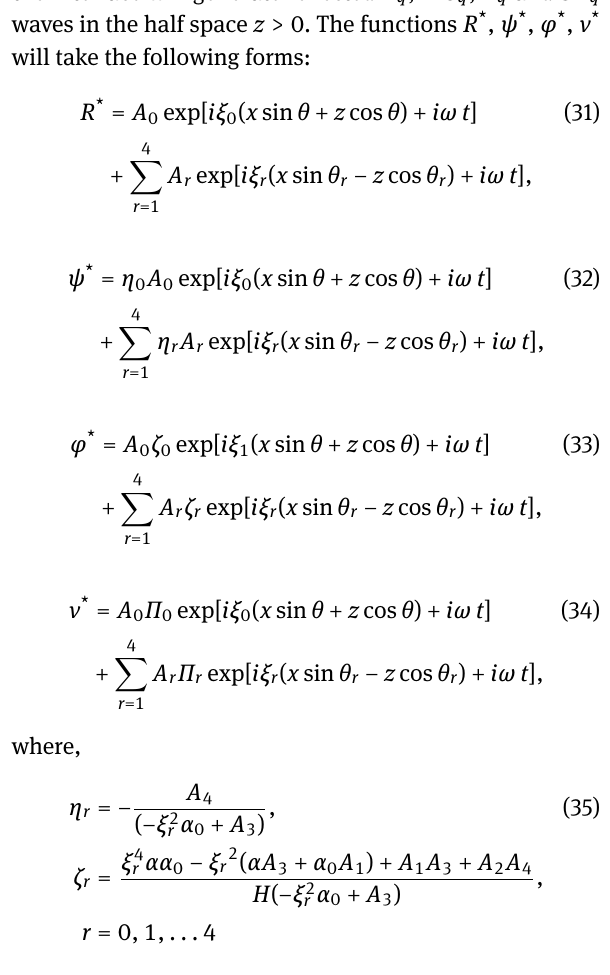
, MC , T and SV q q q q